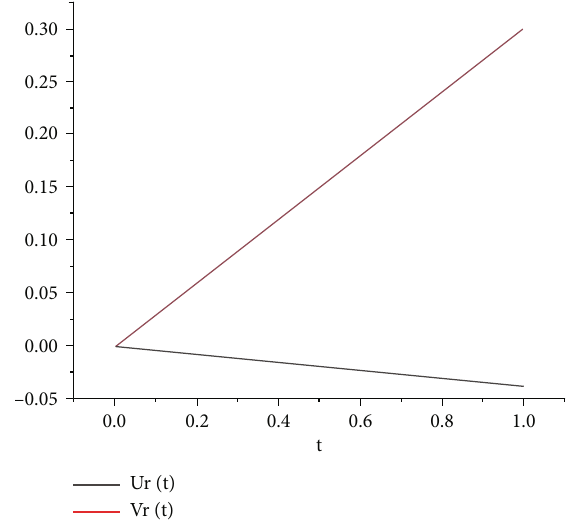
Figure 2: Graphical solution of the Example 23 for the function r ð t Þ = 2 t + 1/t